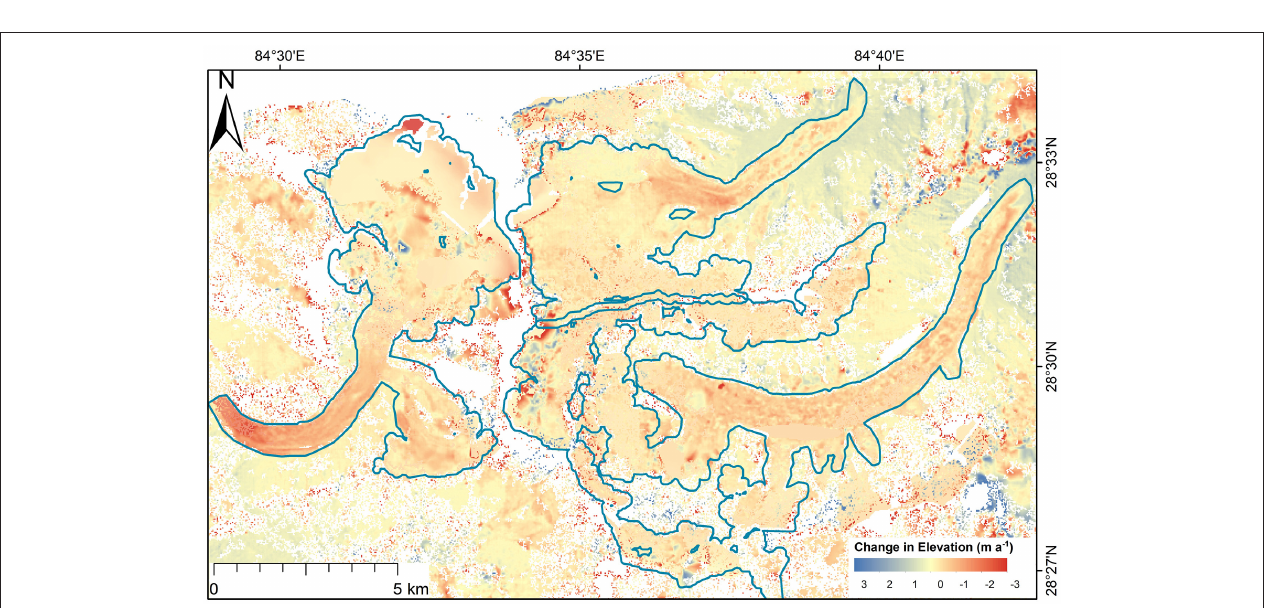
FIGURE 5 | Change in surface elevation for glaciers in the Manaslu region between 2000 and 2013. Changes are shown for the northern glaciers (A) and southern glaciers (B) . The glacier outlines shown are from 2013. Background: Landsat 8 (26th December 2013).